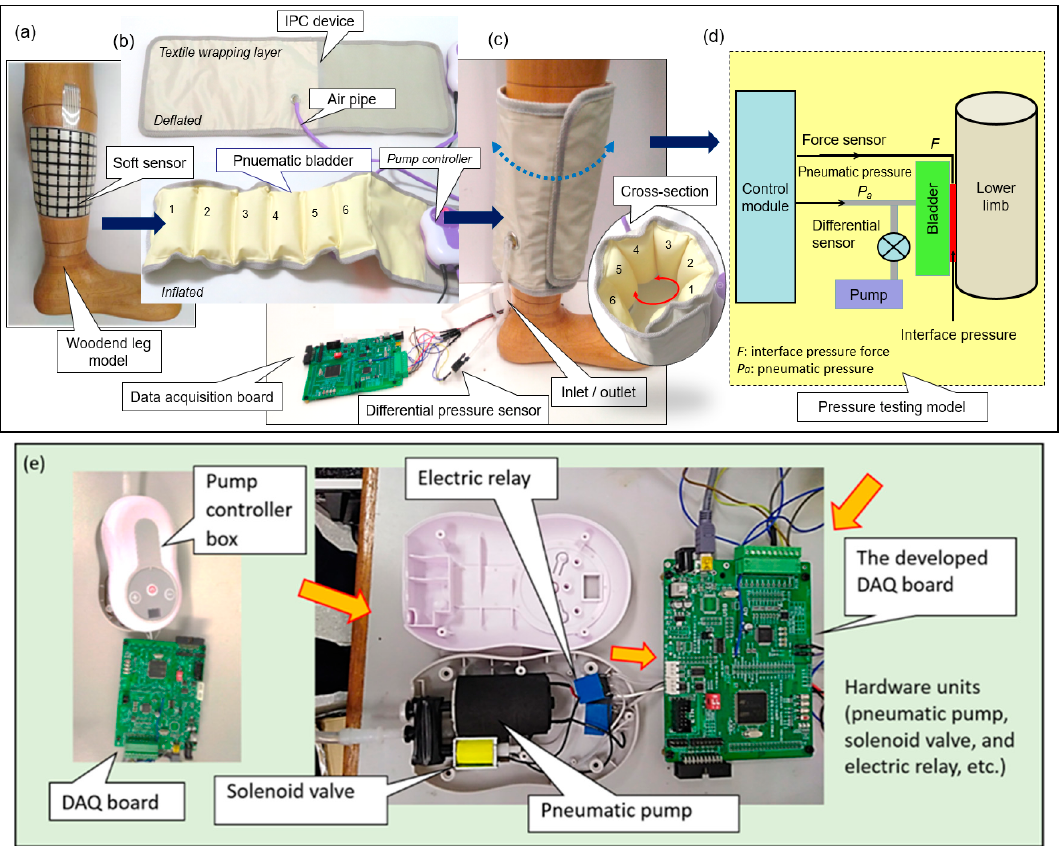
Figure 4. The dynamic pressure monitoring system. ( a ) Matrix soft sensor wrapped on the wooden leg model; ( b ) IPC device in deflation and inflation conditions; ( c ) Monitoring system acting on the wooden leg model with IPC device; ( d ) The developed dynamic interface pressure and pneumatic pressure testing model; ( e ) The developed data acquisition (DAQ) board and the controller box (involving pneumatic pump, solenoid valve and electric relay).